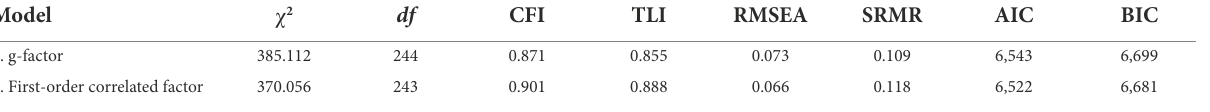
TABLE 2 Goodness-of-fit indices of alternative CFA models. Model